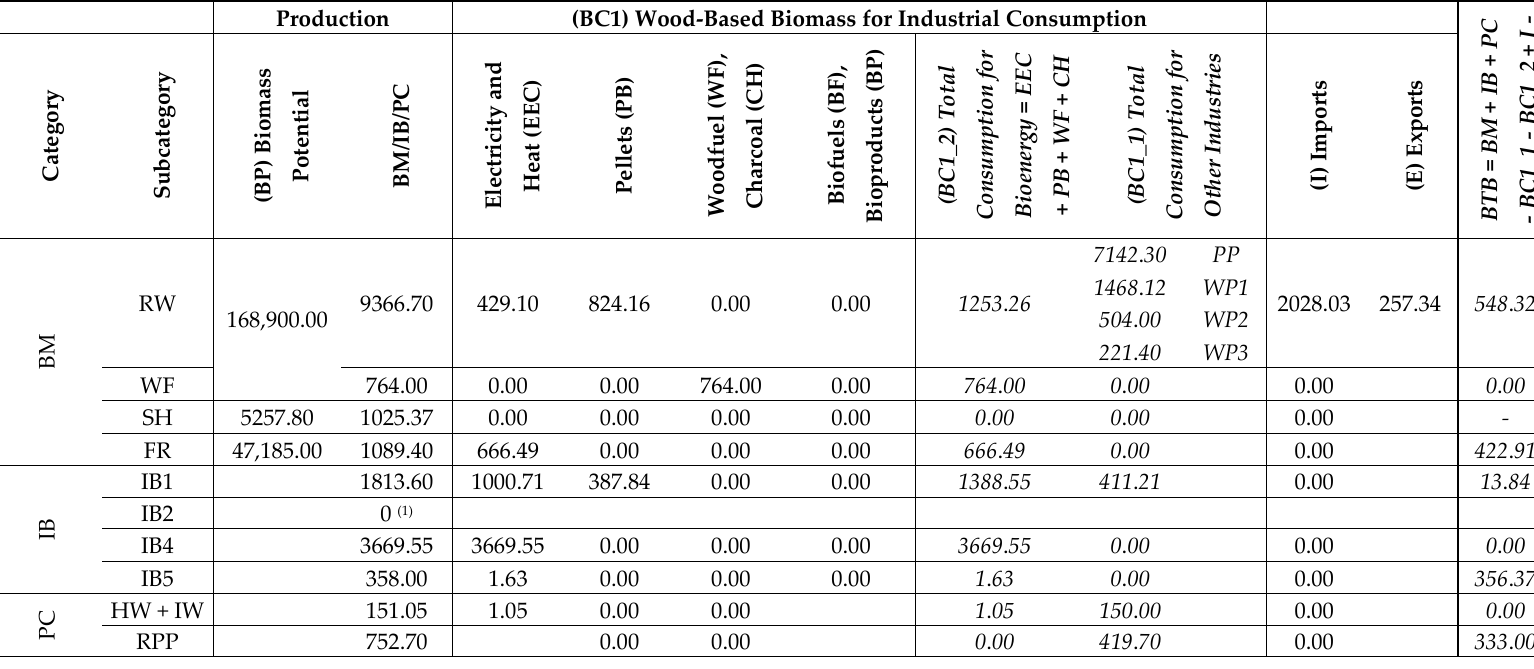
Table 4. Wood-based biomass resource balance table (Portugal mainland, 2016) (kton).